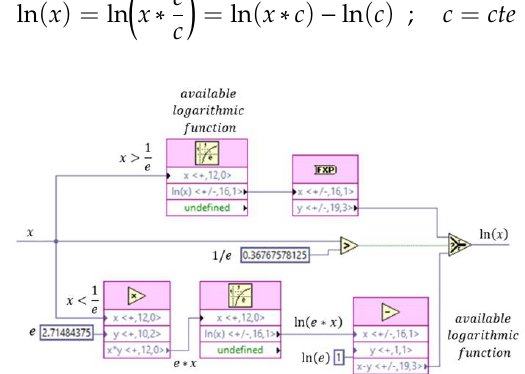
Figure 10. Algorithm used to calculate the natural logarithm.